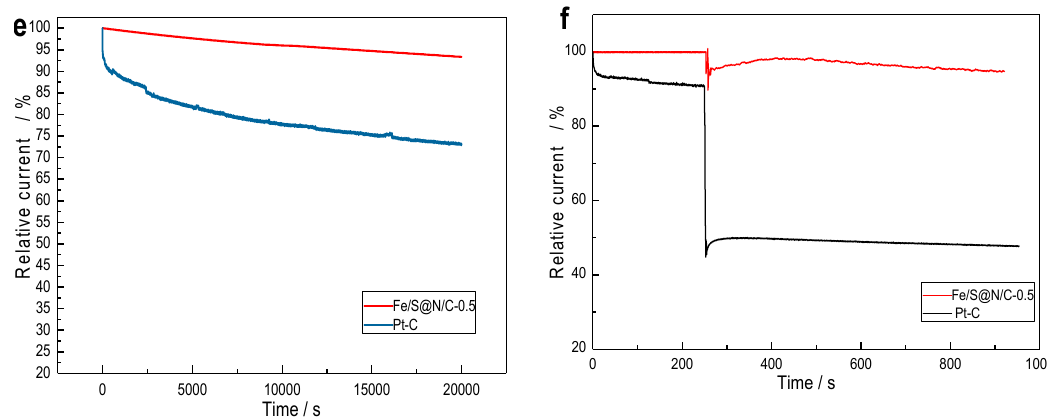
Figure 3. The oxygen reduction reaction (ORR) performance of Fe / S@N / C-x in 0.1 M KOH solution. ( a ) CV curves of Fe / S@N / C-x. ( b ) Linear sweep voltammogram (LSV) curves of Fe / S@N / C-x and 20% Pt / C in O 2 -saturated 0.1 M KOH solution at 1600 rpm with a scan rate of 5 mV / s. ( c ) LSV curves of Fe / S@N / C-0.5 with di ff erent rotating rates at a scan rate of 5 mV / s. ( d ) Koutecky–Levich (K-L) equation of Fe / S@N / C-0.5 with di ff erent potentials. ( e , f ) Stability curves and methanol tolerance curves for Fe / S@N / C-0.5 and 20% Pt / C catalysts in O 2 -saturated 0.1 M KOH at 1600